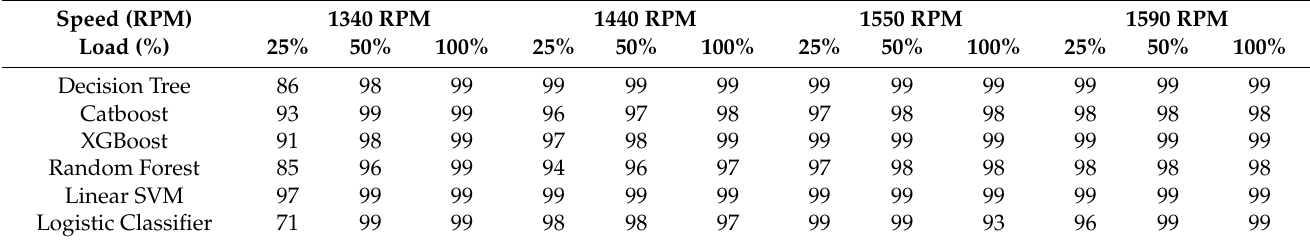
Table 4. Validation accuracy of all six measured signals in different operating conditions.